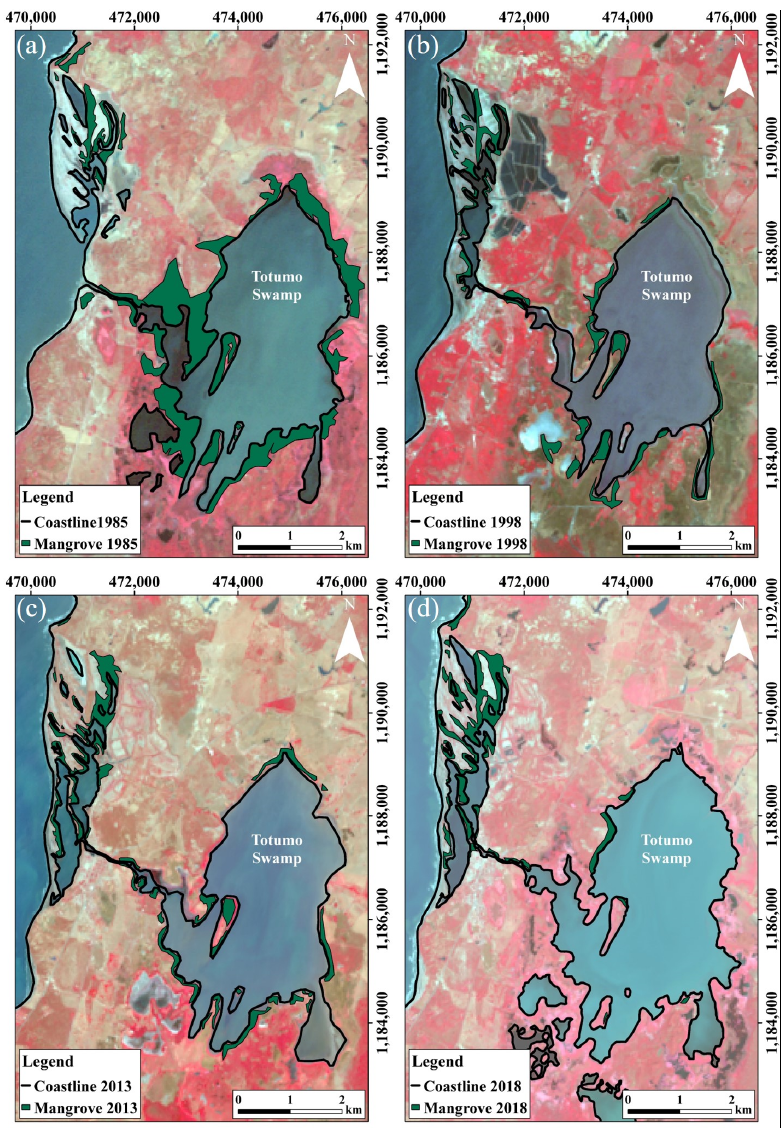
Figure 4. Evolution of the mangrove forest (green) in the Totumo swamp: ( a ) 1985, ( b ) 1998, ( c ) 2013, and ( d ) 2018.